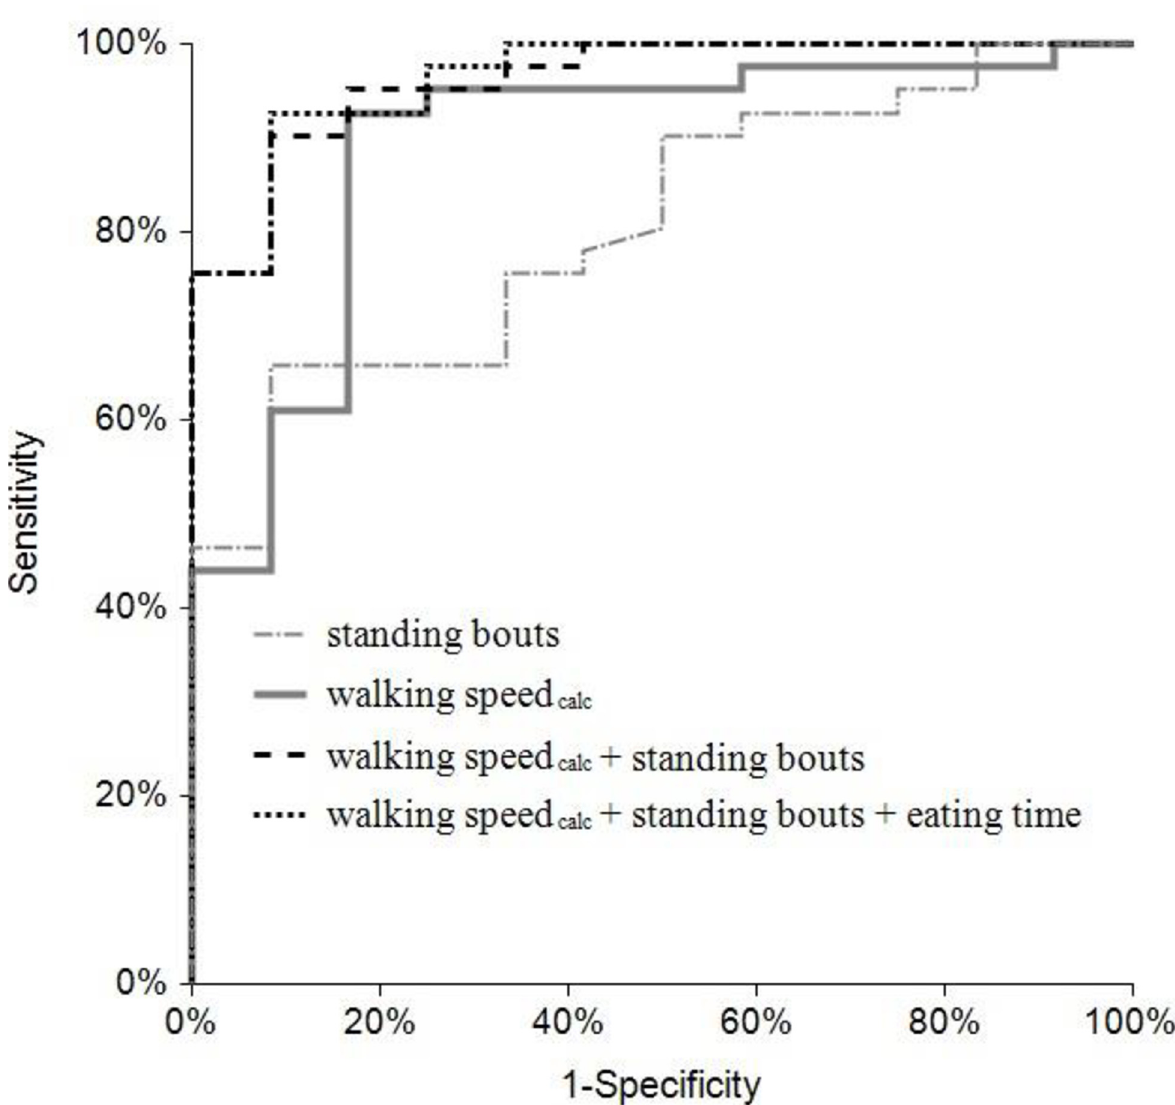
Fig 3. Receiver operating characteristics (ROC) curves of different logistic regression models to discriminate between lame (NRS (cid:1) 2.5) and non-lame cows (NRS (cid:3) 2). First model (- (cid:4) -) includes standing bouts (AUC = 0.81), second model ( ─ ) includes walking speed calc (AUC = 0.88); third model (- -) includes walking speed calc and the number of standing bouts (AUC = 0.96); fourth model ( (cid:4)(cid:4)(cid:4) ) includes walking speed calc , the number of standing bouts and the eating time (AUC = 0.96). NRS = numerical rating system according to Flower and Weary [38]. AUC = area under the receiver operating characteristics